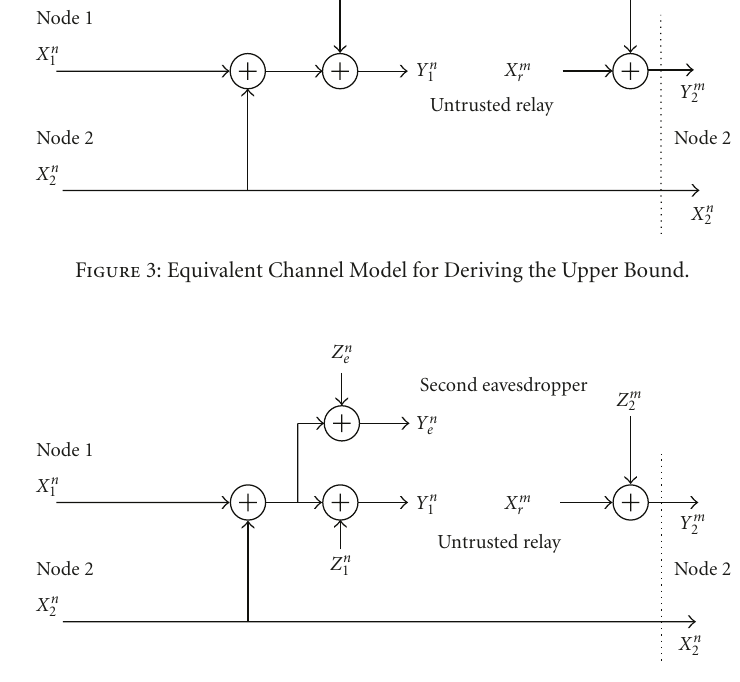
Figure 4: Two-eavesdropper